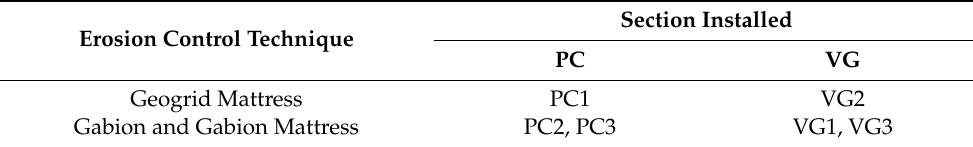
Table 2. Erosion control techniques evaluated and respective installation site.